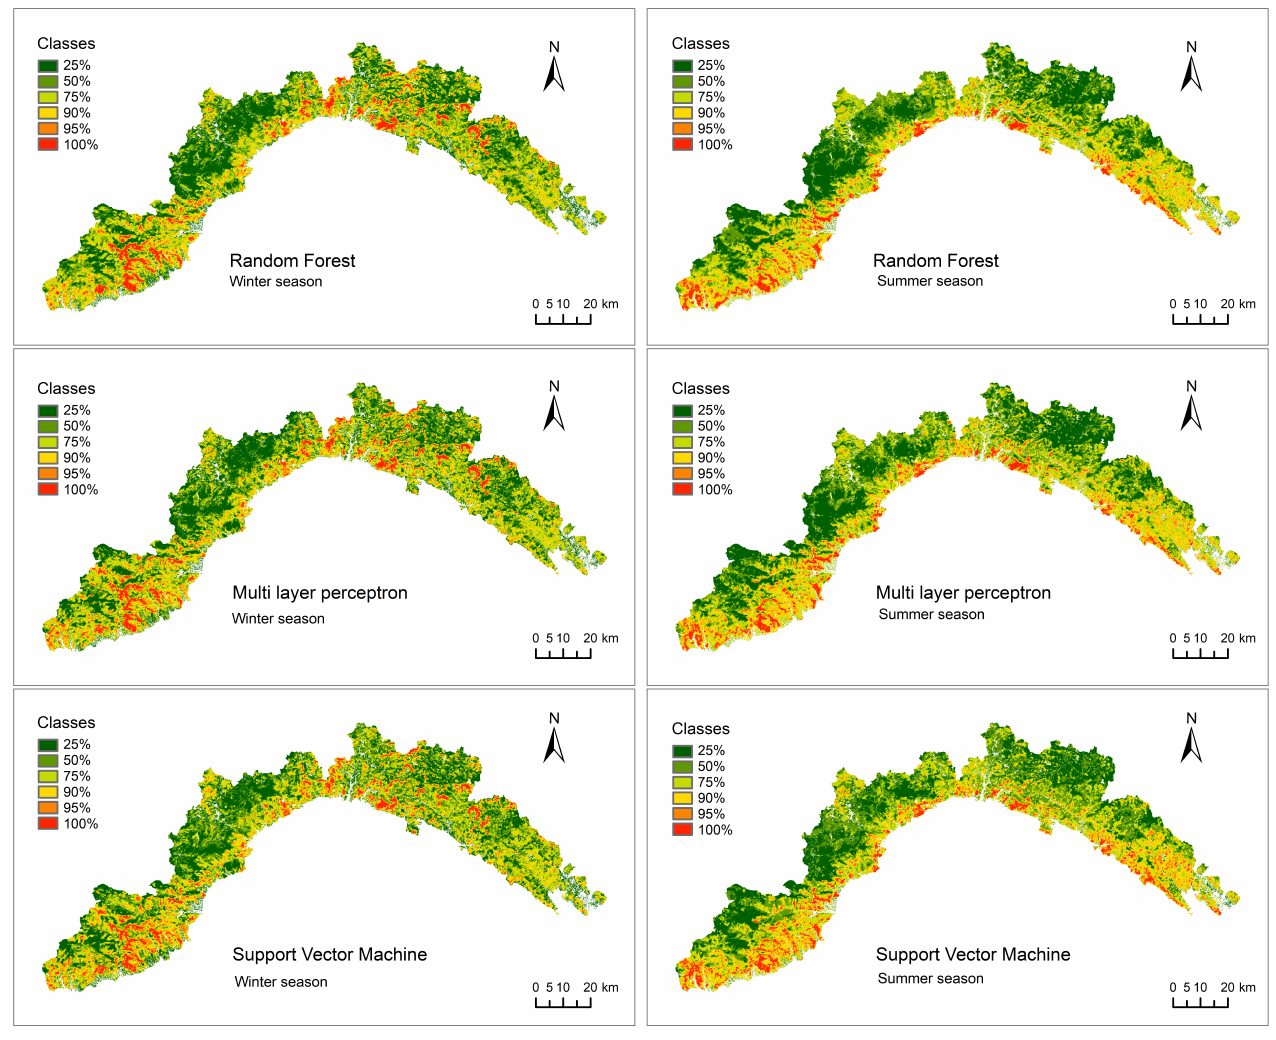
Figure 7. Susceptibility